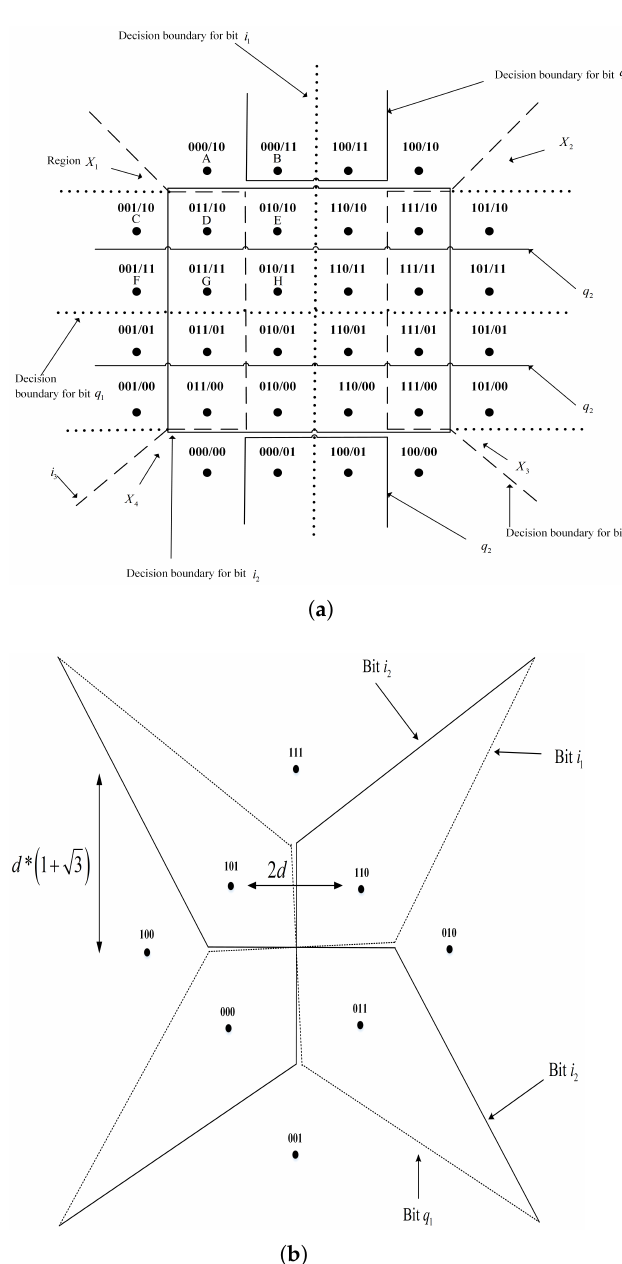
Figure 2. Constellations and decision boundaries of ( a ) XQAM-32DCSK and ( b ) XQAM-8DCSK. It should be noted that the slash is used to distinguish the I and Q signals for the XQAM-32DCSK constellation. In the XQAM-8DCSK constellation, the first bit and the third bit are I signals, while the second bit is Q